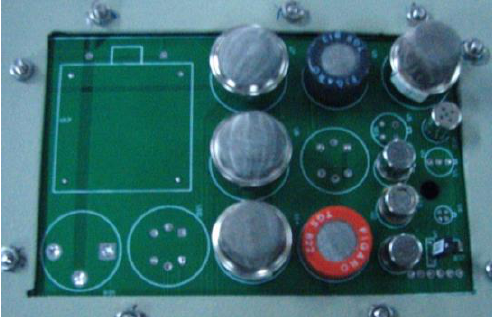
Figure 2. Electronic nose (E-nose) prototype.